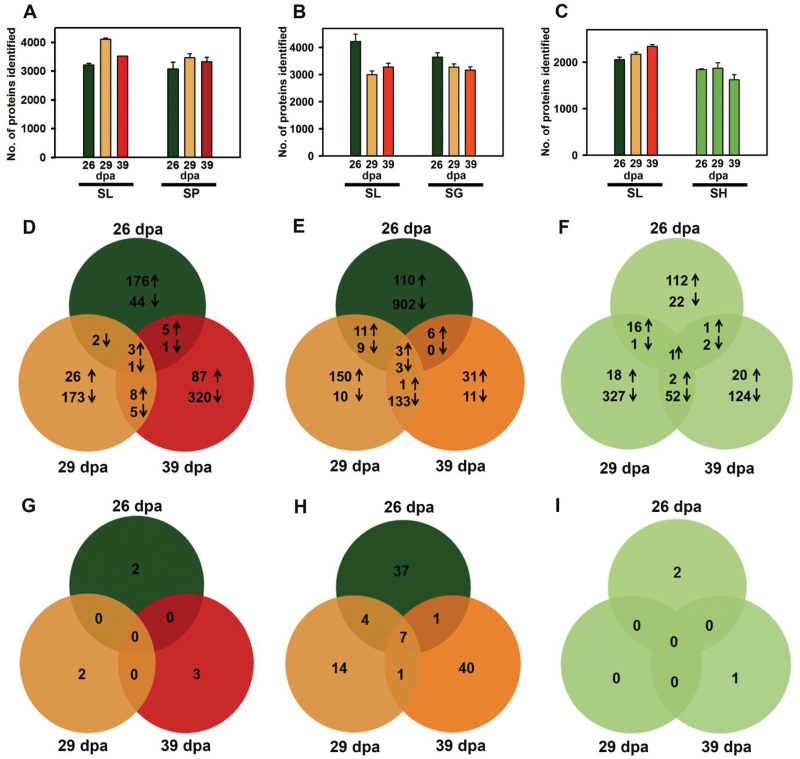
Proteome analyses from the fruits of tomato and wild species. The fruits were harvested at 26, 29, and 39 dpa. Data are means±SE (n=3), P≤0.05; up-regulation (↑), down-regulation (↓)]. (A–C), Number of proteins identified in fruits. (A) SP and SL; (B) SG and SL; (C) SH and SL. (D–F) Differentially expressed proteins in wild species in comparison with SL and listed in Table S4. (D) SP; (E) SG; (F) SH. (G–I) Proteins identified solely in wild species and listed in Table S5. (G) SP; (H) SG; (I) SH. (This figure is available in color at JXB online.)